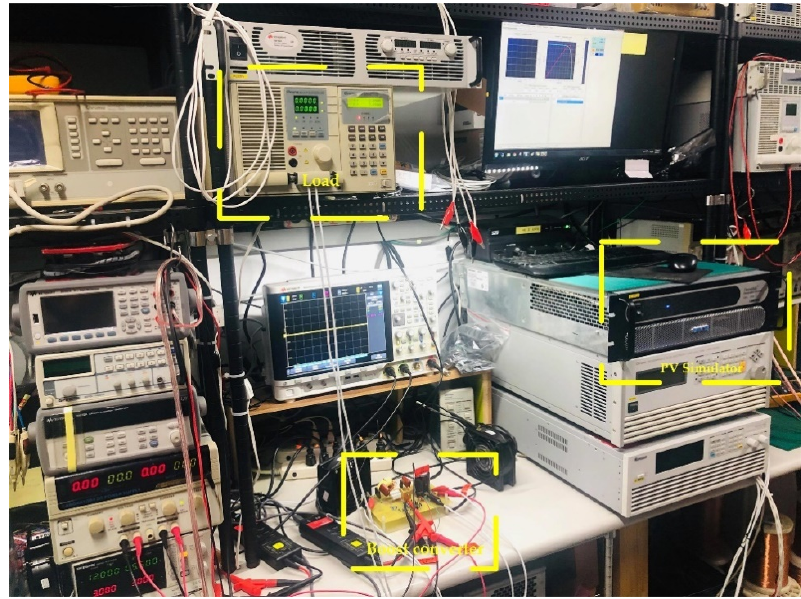
Figure 8. Experimental setup and the testing environment.